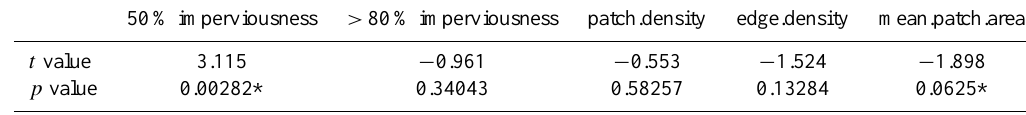
Table 2. Different p value of runoff yield change versus impervious area and landscape metrics. 50% imperviousness > 80%